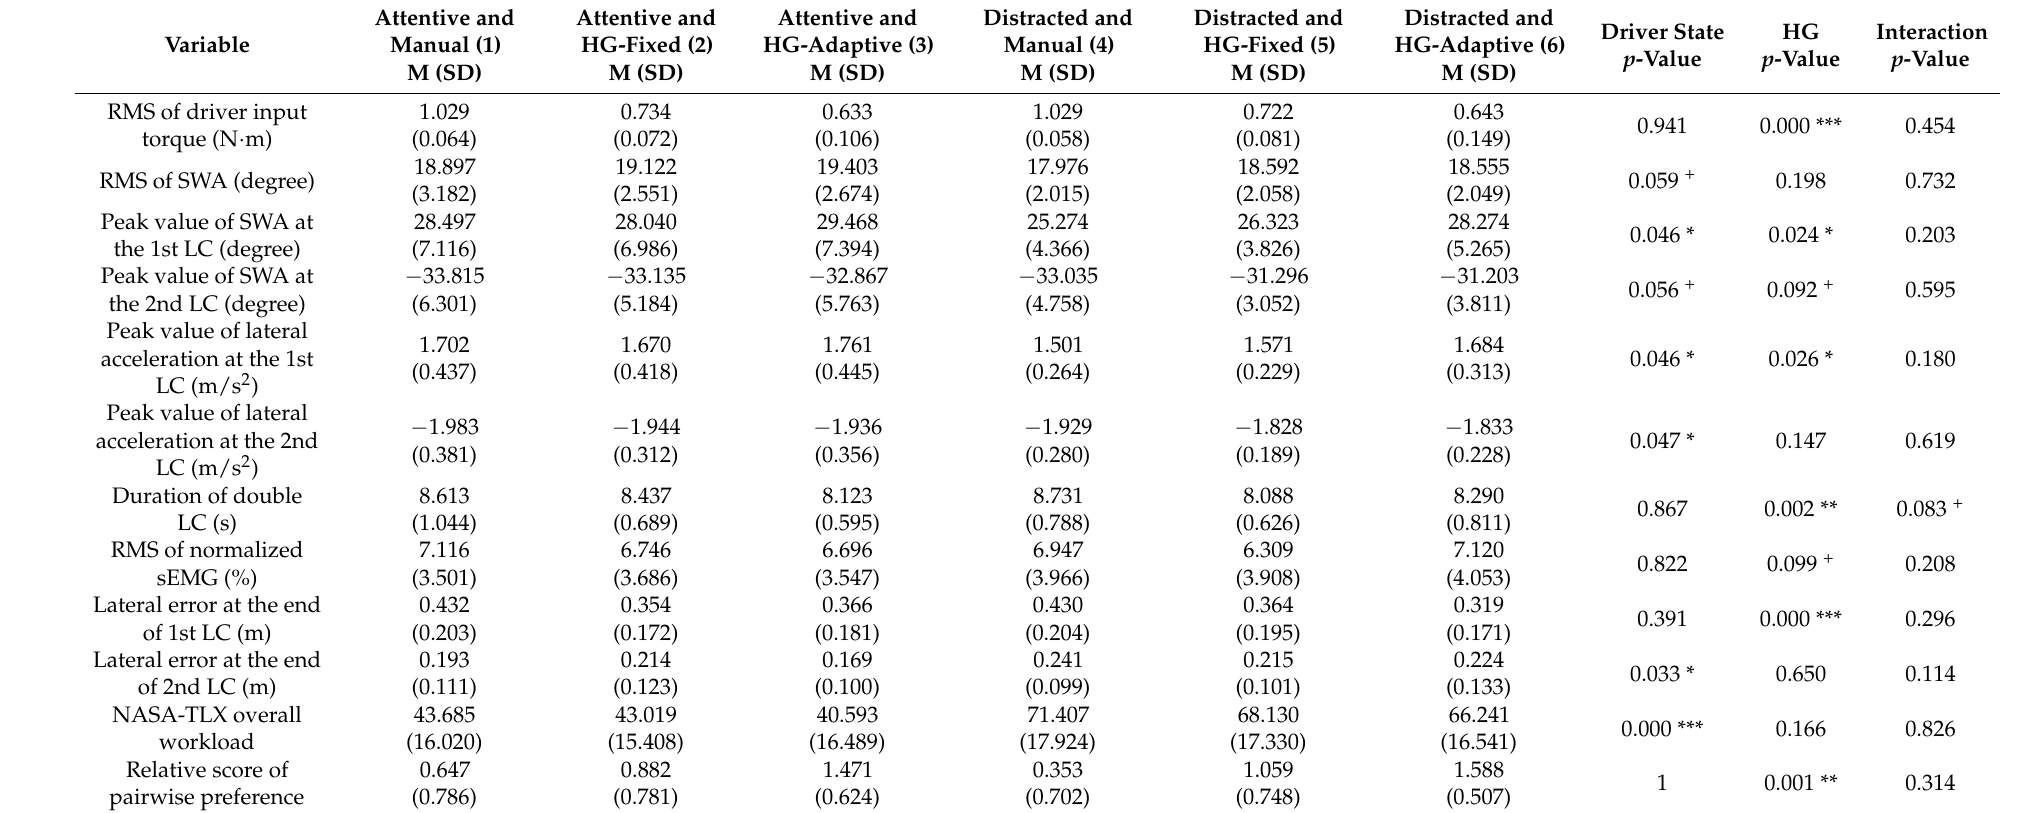
Table 2. Experimental